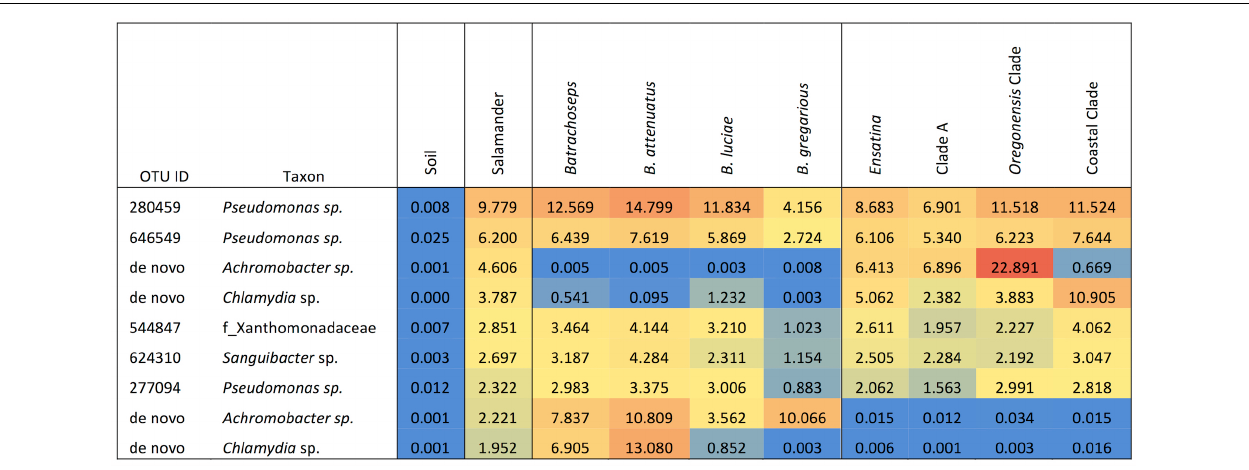
Frontiers in Microbiology |